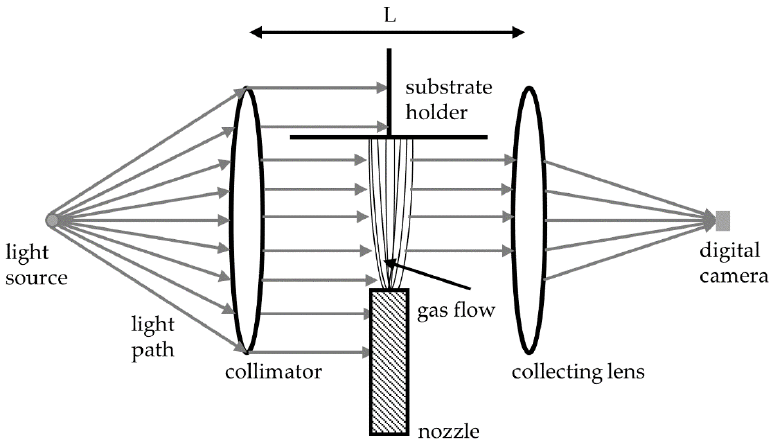
Figure 5. Scheme of a shadow imaging system consisting of a light source, collimating and collecting lens, and a camera system adjusted around the nozzle-substrate-setup. The influence of the gas density distribution on the film formation is investigated in two experimental steps. Different parameter sets were investigated with the shadow im- aging system without particle feeding. Corresponding coatings were produced by the PAD using a powder-laden gas, with otherwise identical flow parameters. The gas flow rate and the chamber (back)pressure were the main varied parameters. Nitrogen served as carrier gas at flow rates of 10, 15, and 20 standard liters per minute (slm). One slm is equivalent to 0.075 kg/h here. All gas flow rates were applied at the minimal possible (back)pressure in the vacuum chamber. In addition, 10 mbar, 15 mbar, and 20 mbar cham- ber pressures were set at all gas flow rates in order to obtain an experimental matrix. The stand-off distance between the substrate and nozzle were kept constant at 10 mm. The same slit nozzle was used in all experiments. 2.2. PAD Eexperiments For the MgB 2 coatings on glass substrates, a powder supplied by Alfa Aesar and jet milled down to a particle size of d 90 < 5.4 µm by DEC, Ecublens/Lausanne Switzerland was used. The parameter sets used for coating preparation are given in the section “ shadow optical experiments ” (also cf. Table 1), and so is the nozzle used. The aerosol was gener- ated with a RBG 1000 aerosol generator from Palas GmbH, Karlsruhe, Germany. Hanft et al. have already shown that this generator provides a well-defined aerosol that is suitable for PAD [6]. The particle concentration was maintained constant for all prepared films by adjusting the powder feed velocity of the aerosol generator. To provide the same powder mass of approximately 0.75 g for each single deposition process, the number of scans was adjusted accordingly. At a gas flow rate of 10 slm and a chamber pressure of 20 mbar, no coating was produced.